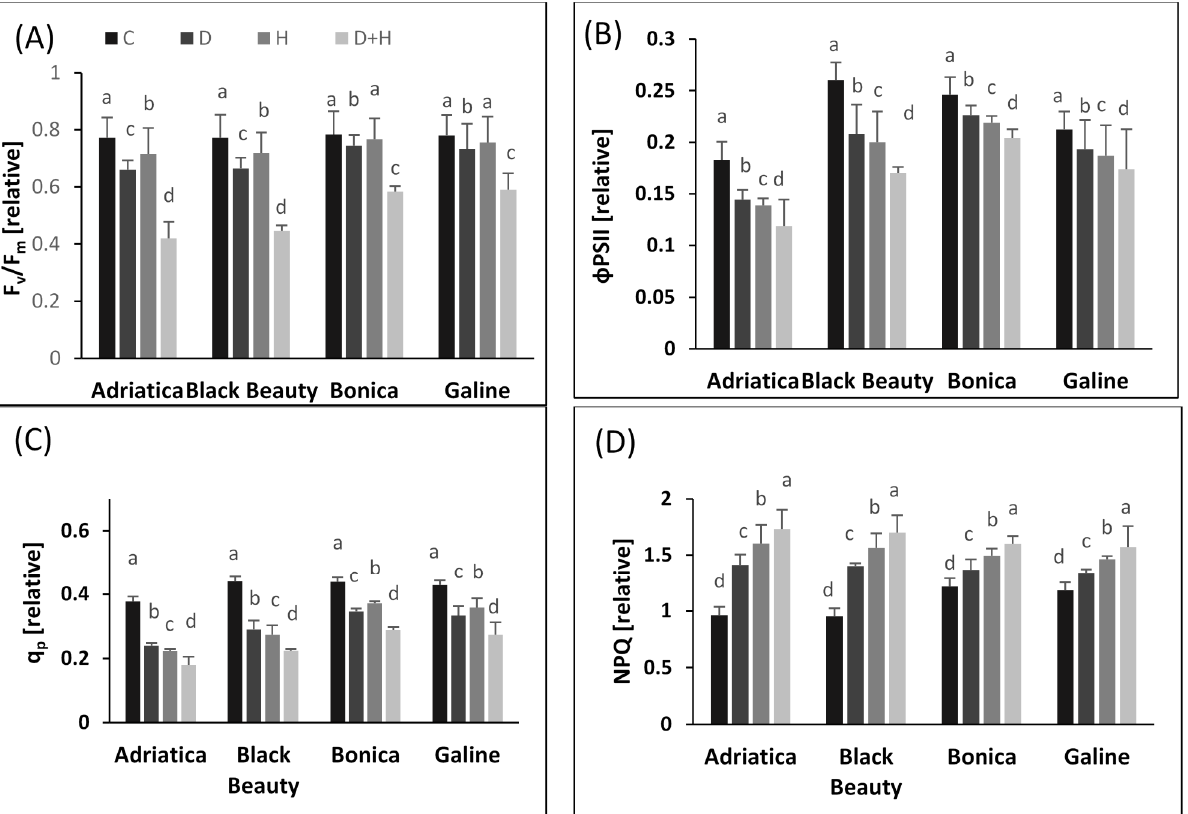
Figure 1. Effect of single and associated stresses on chlorophyll fluorescence parameters in four eggplant varieties. ( A ): PSII efficiency (F v /F m ); ( B ): PSII quantum yield ( Φ PSII); ( C ): photochemical efficiency (q p ); ( D ): non-photochemical quenching (NPQ). Data represents means ± SE ( n = 5). Significant dissimilarities are shown by different lower-case letters between treatments ( p ≤ 0.05) based on Tukey’s test. (C, control; H, heat stress; D, drought stress; H + D, heat + drought stresses).